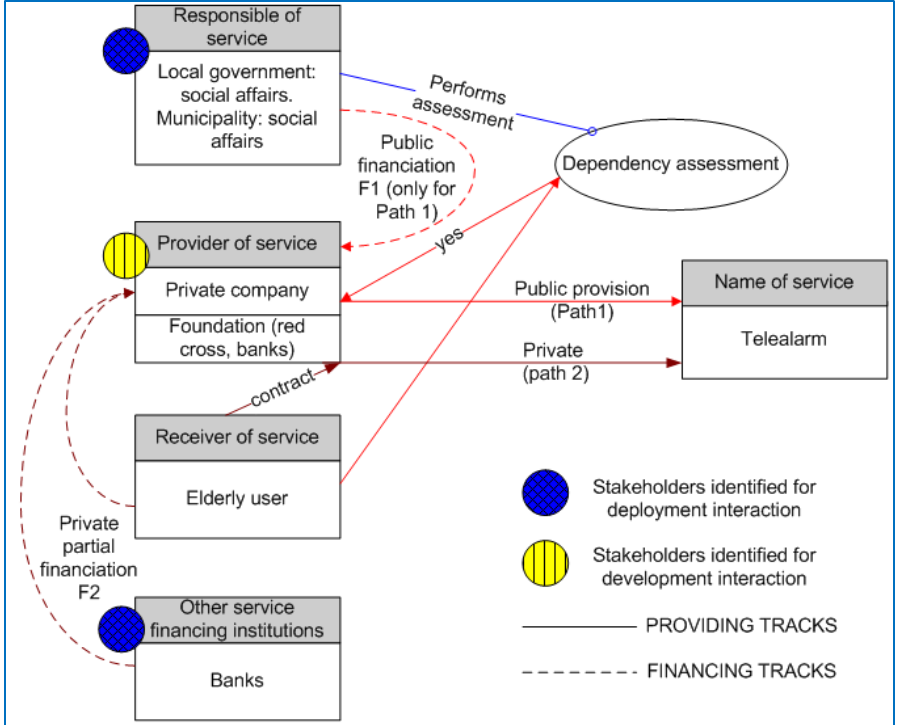
Figure 9. Financial and provision paths for service using service